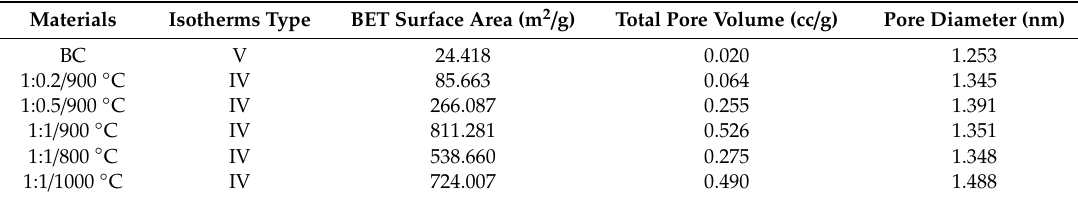
Table 2. Adsorption parameters of di ff erent